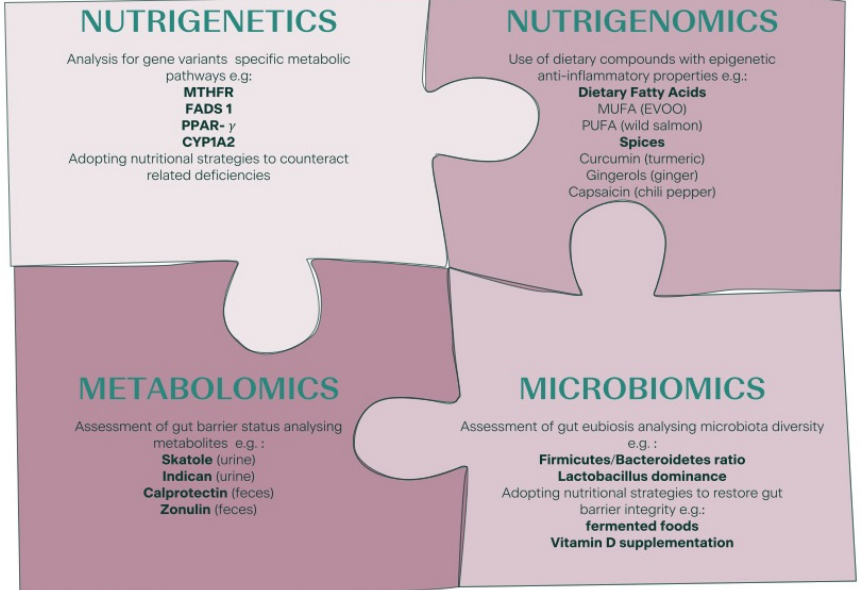
Figure 2. Personalized nutrition in the management of female infertility: practical examples of nutrigenetics, nutrigenomics, microbiomics, and metabolomics aspects to consider. Methylenetetrahydrofolate Reductase ( MTHFR ); Fatty Acid Desaturase 1 ( FADS 1 ); peroxisome proliferator-activated receptor gamma ( PPAR - γ ); Cytochrome P450 1A2 ( CYP1A2 ); Monounsaturated Fatty Acids (MUFA); Polyunsaturated Fatty Acids (PUFA).